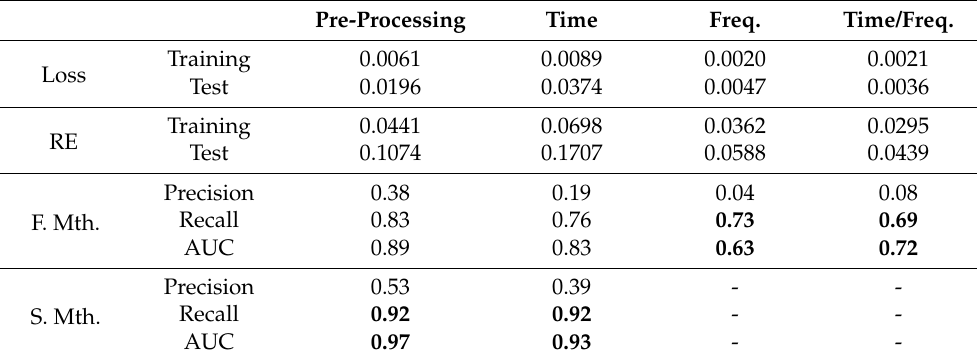
Table 4. DT performance in different parts and domains (cells in bold report best